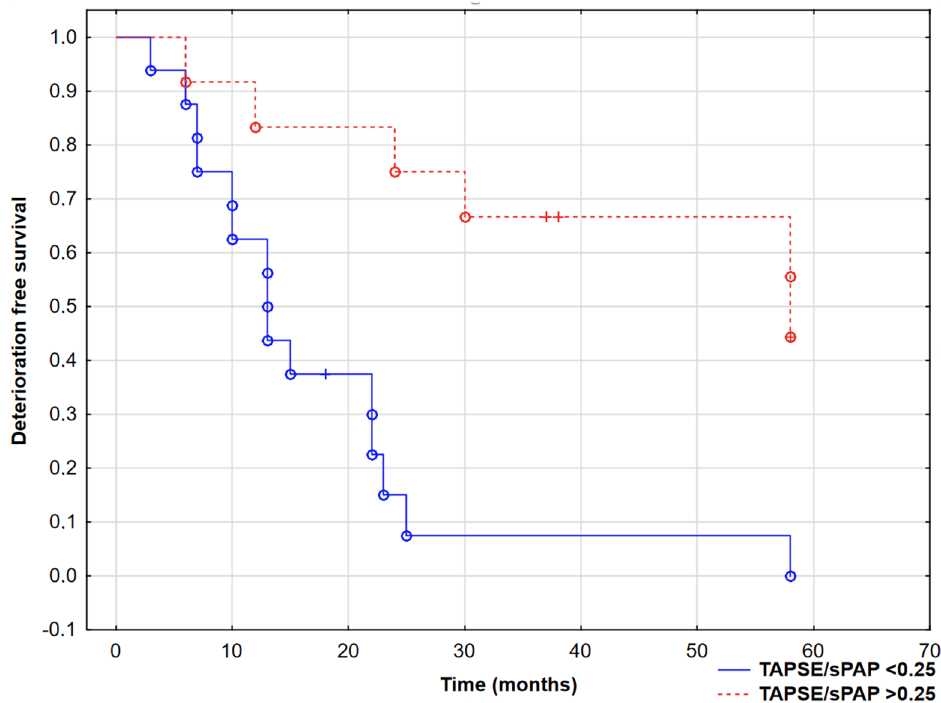
Figure 3. Kaplan–Meier curves presenting deterioration-free survival in PAH patients based on TAPSE/sPAP ratio, log-rank test, p = 0.0004. °—complete events, +—censored events.